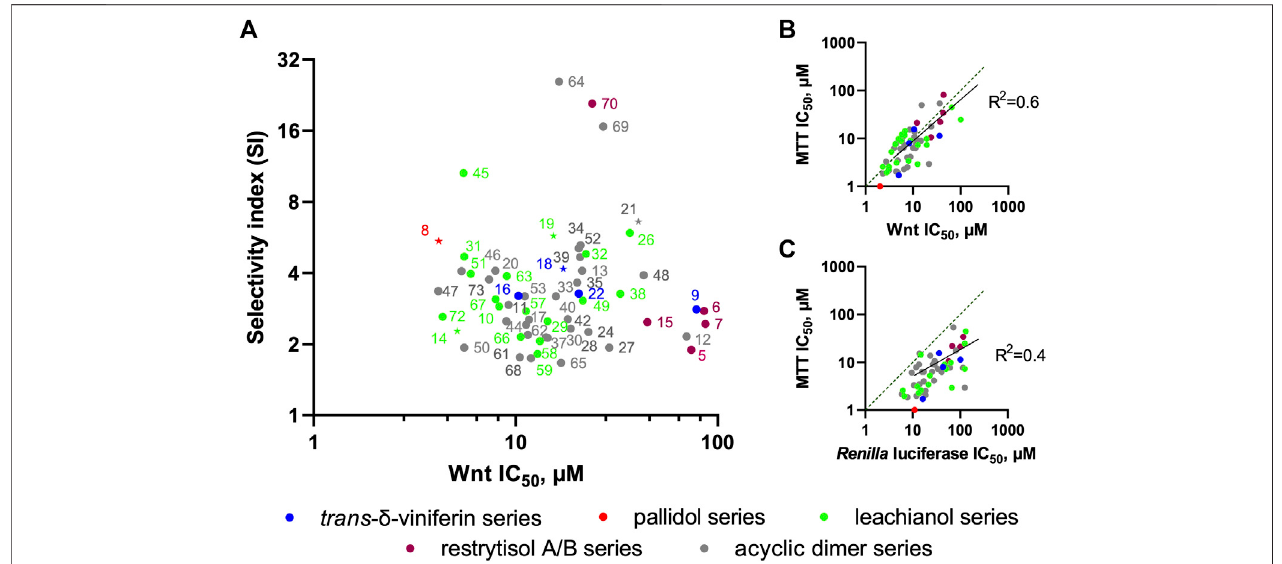
FIGURE8| Relations between derivative scaffolds and anti-Wnt activity. (A) Distribution between theselectivityindex (SI) and anti-Wnt potency oftheinvestigated compounds. The compounds selected for further biochemical analysis are highlighted as stars (B) Correlation between anti-Wnt IC 50 and IC 50 of long-term (3 days) inhibition of the cell growth measured by MTT assay (C) Correlation between anti-Wnt IC 50 and IC 50 of acute cytotoxicity.